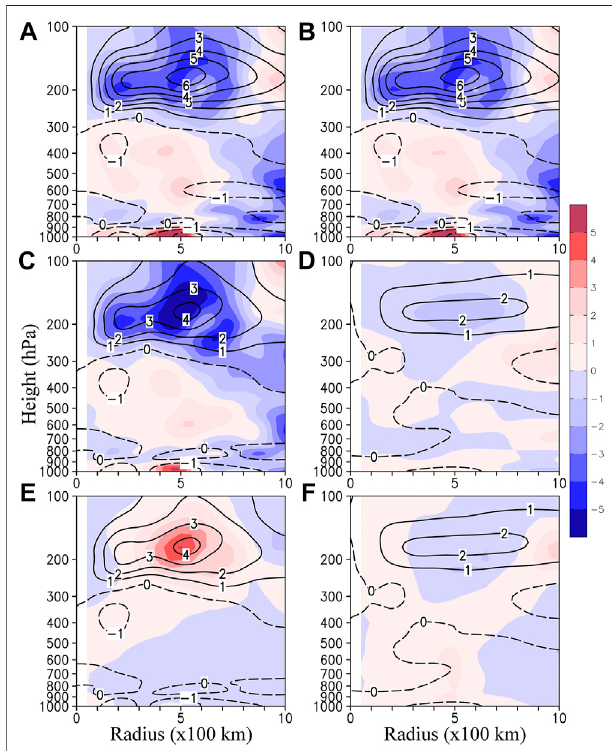
FIGURE 5 | Radius-height cross-sections of the azimuthal-mean horizontal fl uxdivergenceofAAM(AAMFD,shaded,10 5 m 3 s − 1 h − 1 )andradial wind (contours, m s − 1 , solid and dashed lines are for out fl ow and in fl ow, respectively)at1800UTCSep17,2006 (A) totalAAMFDandradialwind (B) sum of the RHS AAMFD terms of Eq. 4 and total radial wind (C) AAMFD and radial wind associated withthe synoptic-scale circulation (D) AAMFD and radialwindassociatedwiththelow-frequency circulation (E) thedivergenceof low-frequency AAM fl ux by the radial wind associated with the synoptic-scale circulation, and (F) the divergence of synoptic-scale AAM fl ux by the radial wind associated with the low-frequency circulation.